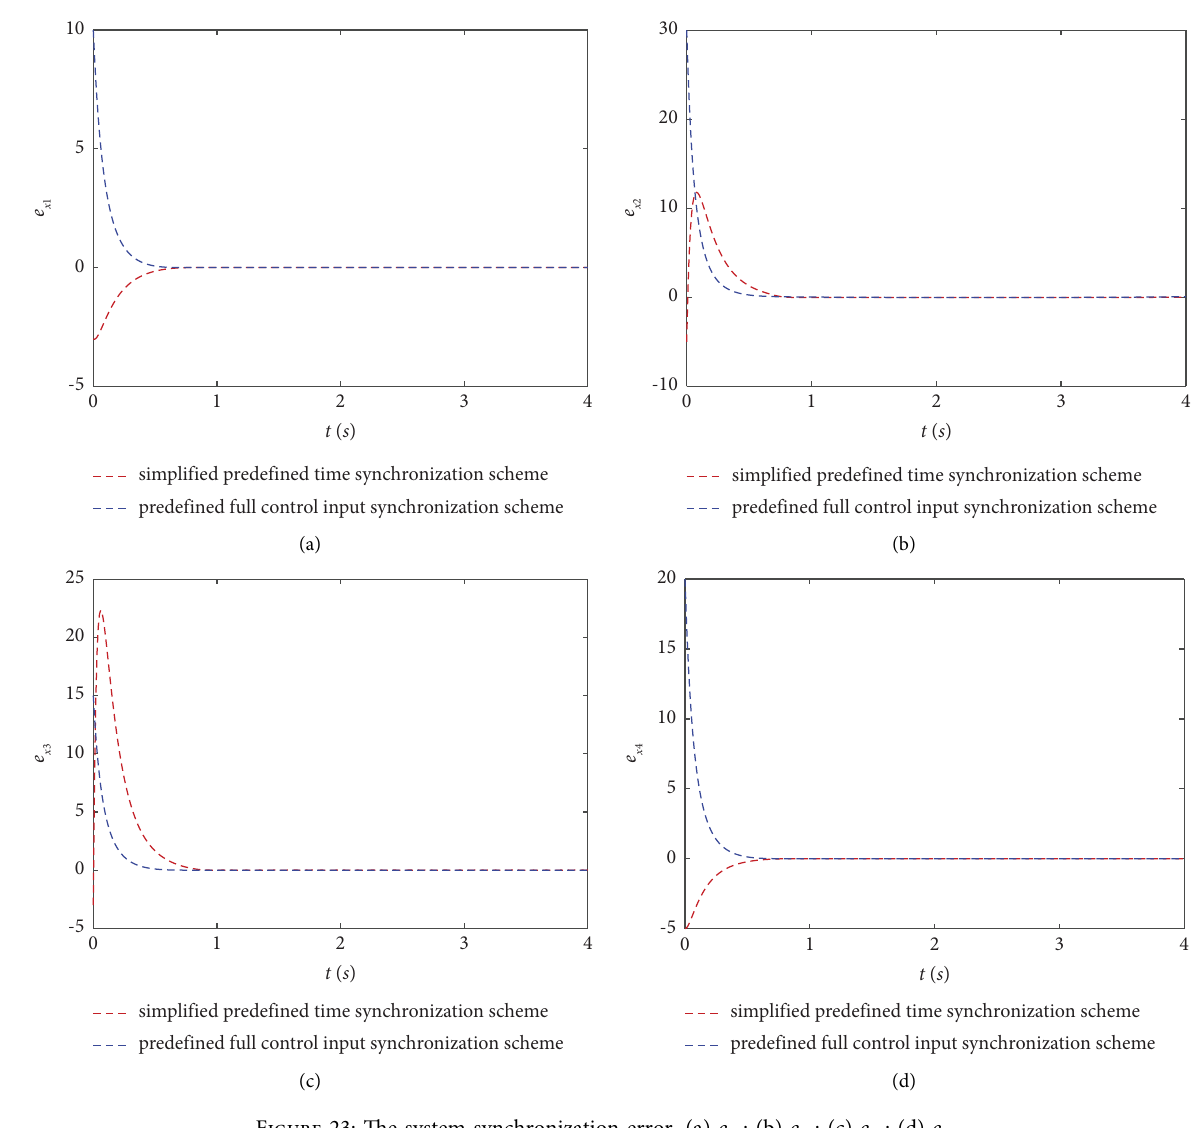
e e e x 1 ; (b) x 2 ; (c) x 3 ; (d) x 4